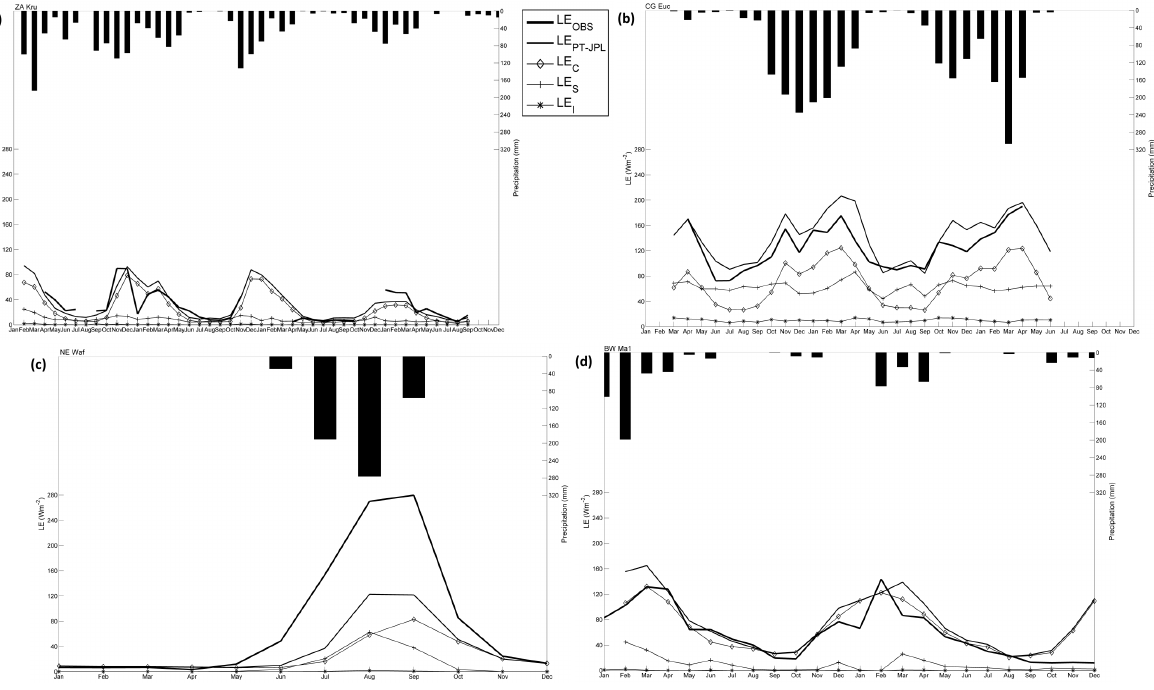
Fig. 1. Monthly observed LE OBS (Wm − 2 ) and modeled LE PT-JPL (Wm − 2 ) plotted on the lower axis and precipitation (mm) plotted on the upper axis using field data from ZA-Kru 2000–2003 (a) , CG-Euc 2004–2006 (b) , NE-Waf 2006 (c) , and BW-Ma1 2000–2001 (d) .